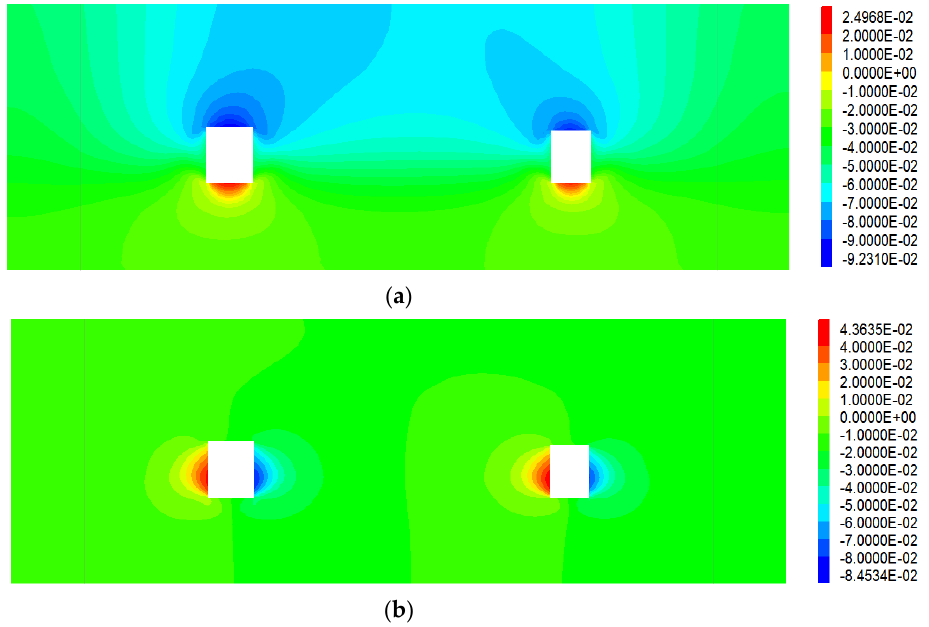
Figure 10. A cavern displacement cloud chart. ( a ) The vertical displacement cloud chart; and ( b ) the horizontal displacement cloud chart.